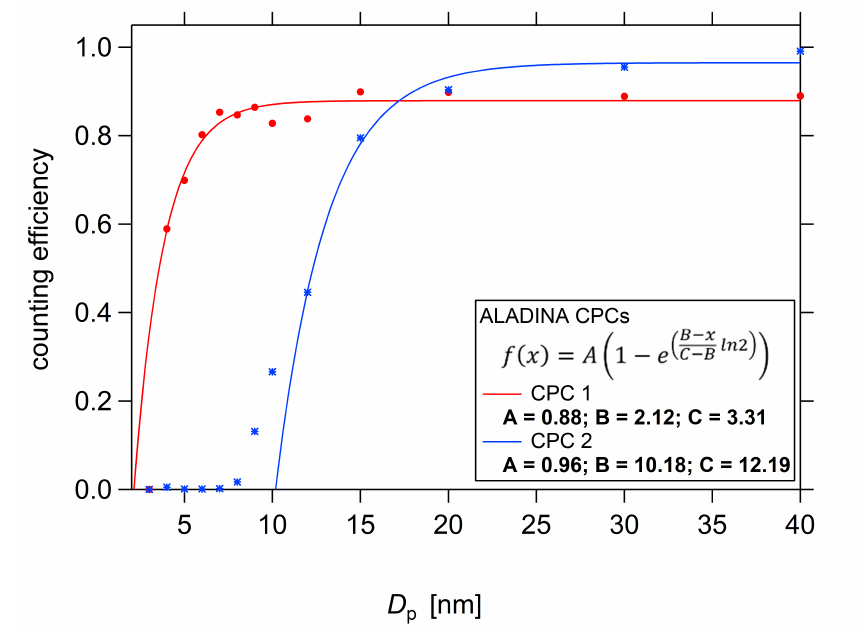
Figure 20. Counting efficiency of the two modified CPCs operated on-board ALADINA. Dots and stars show the measured values at selected diameters, while the line shows a fit according to the equation and coefficients in the textbox above. The D P50 of CPC 1 is 3.3 nm that of CPC 2 is